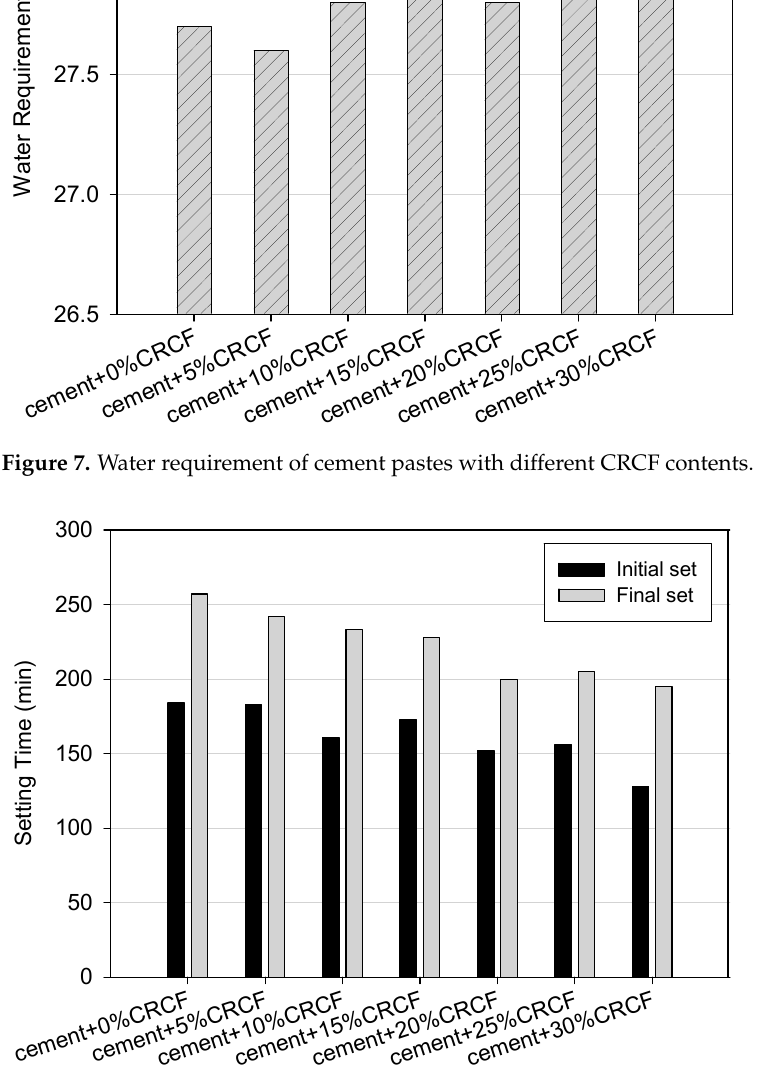
Figure 8. Initial and fi nal se tt ing time of cement samples with di ff erent CRCF contents.